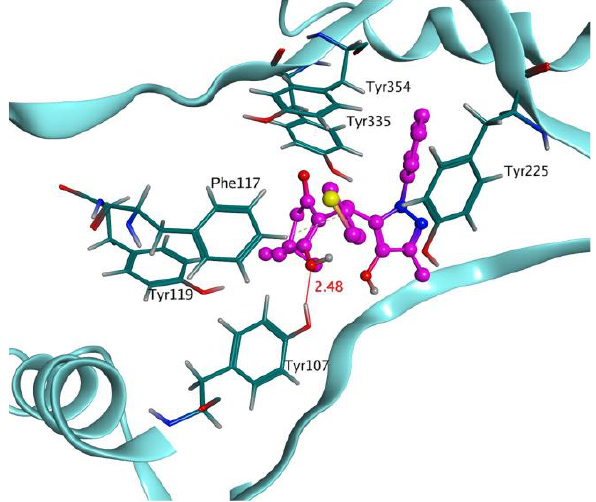
Figure 9. Docking molecular of the compound 21o with N -myristoyl transferase (PDB ID code: 1IYL) from Candida albicans . Image adapted from Barakat et al.